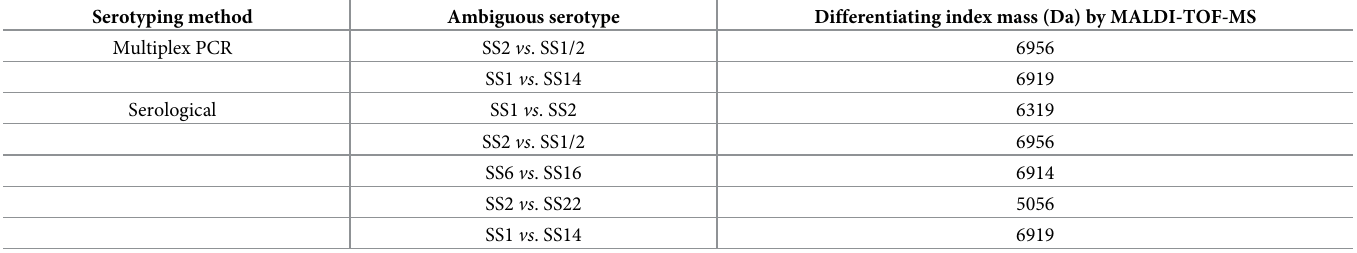
Table 3. Differentiating between serologically ambiguous serotypes using the index mass obtained from MALDI-TOF-MS analysis of PMFs from anaerobically cul- tured S . suis serotypes. Serotyping